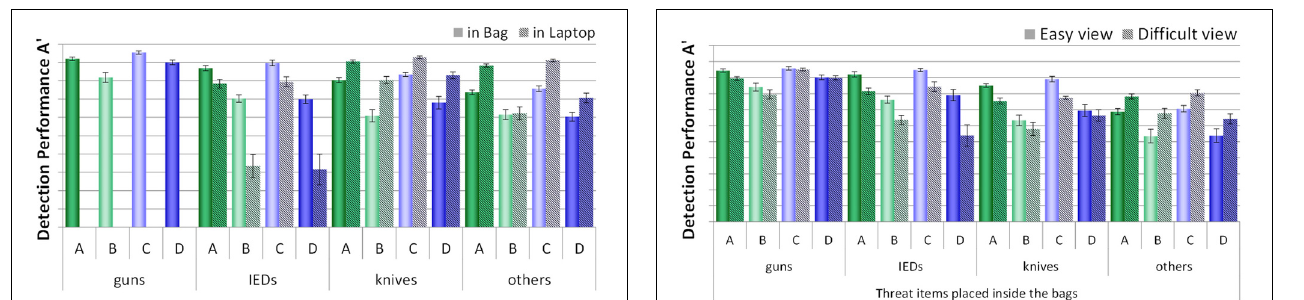
FIGURE 7 | Mean detection performance A’ with standard errors of the mean for all four conditions (A–D) with regard to the view difficulty (easy vs. difficult view) for each threat category (guns, IEDs, knives, others). Only threat items which were placed inside the bags are